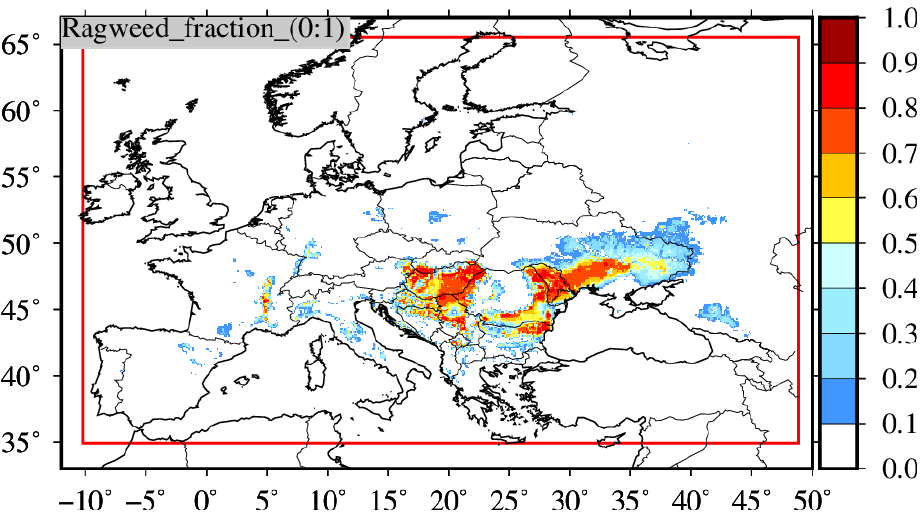
Figure 2. Distribution of ragweed plants over Europe. Data from the CAMS project